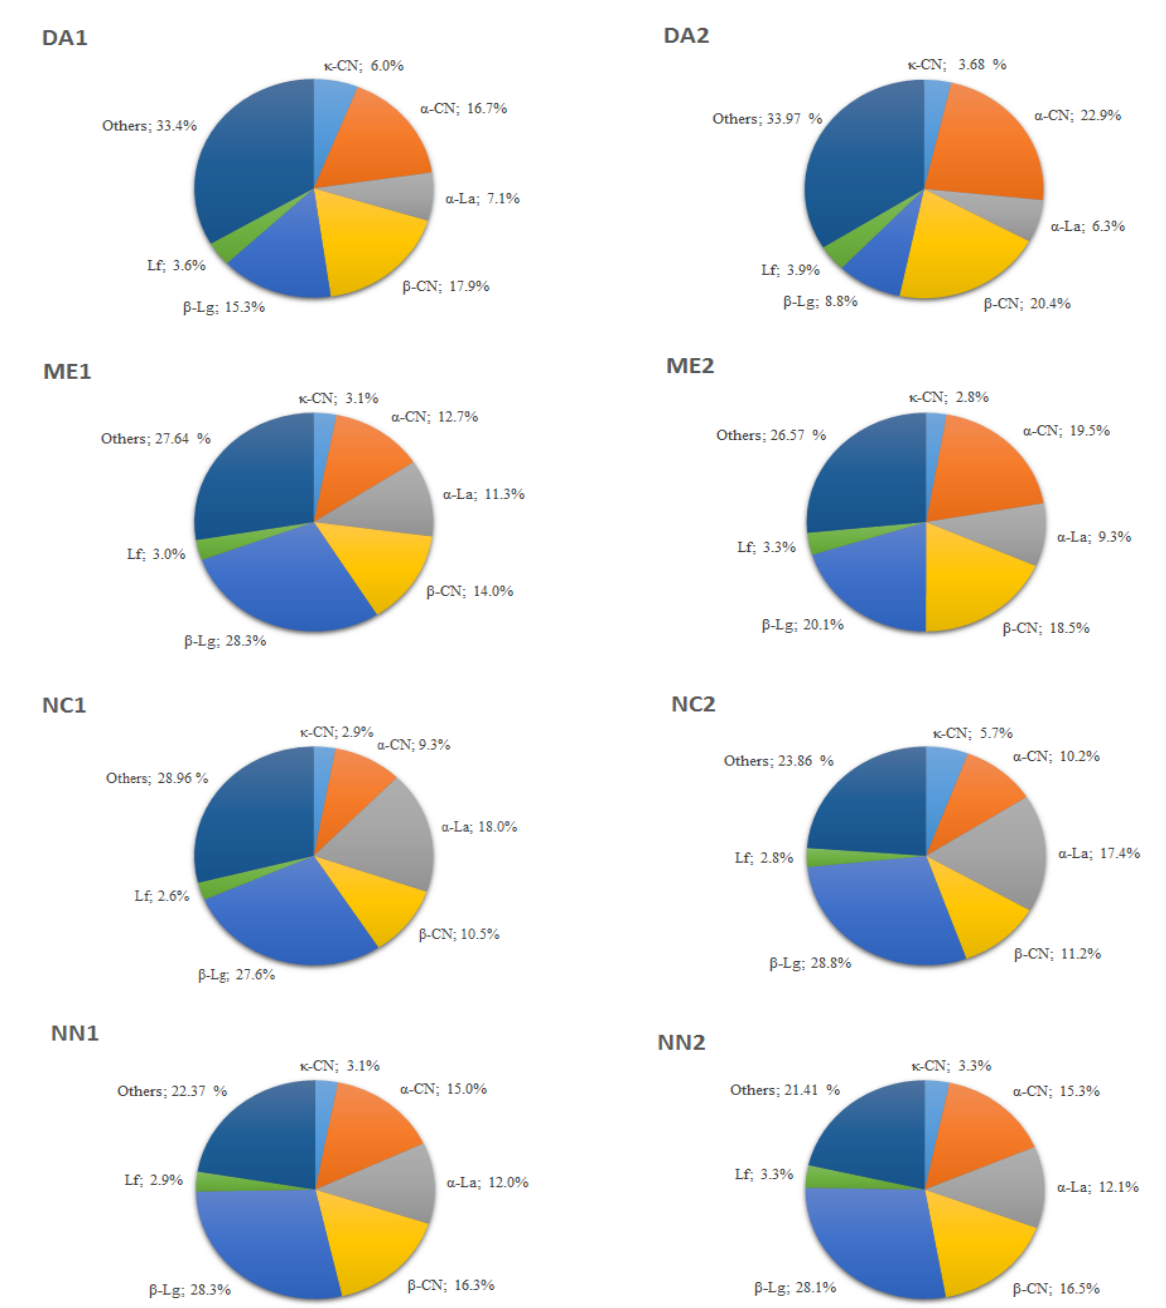
Figure 3. Approximate percentage of protein fractions identified by SDS-PAGE 12% for each infant formula. Lf, lactoferrin; BSA, bovine serum albumin; α -CN, α -casein; β -CN, β -casein; κ -CN, κ -casein; β -Lg, β -lactoglobulin; α -La, α -lactalbumin. Gels were analyzed by TotalLab Quant ® software, in which the apparent volume for each protein band was determined by densitometry. Ratios between whey proteins and caseins were expressed as a percentage using the apparent volume of protein fractions. Unidentified proteins were classified as other proteins.